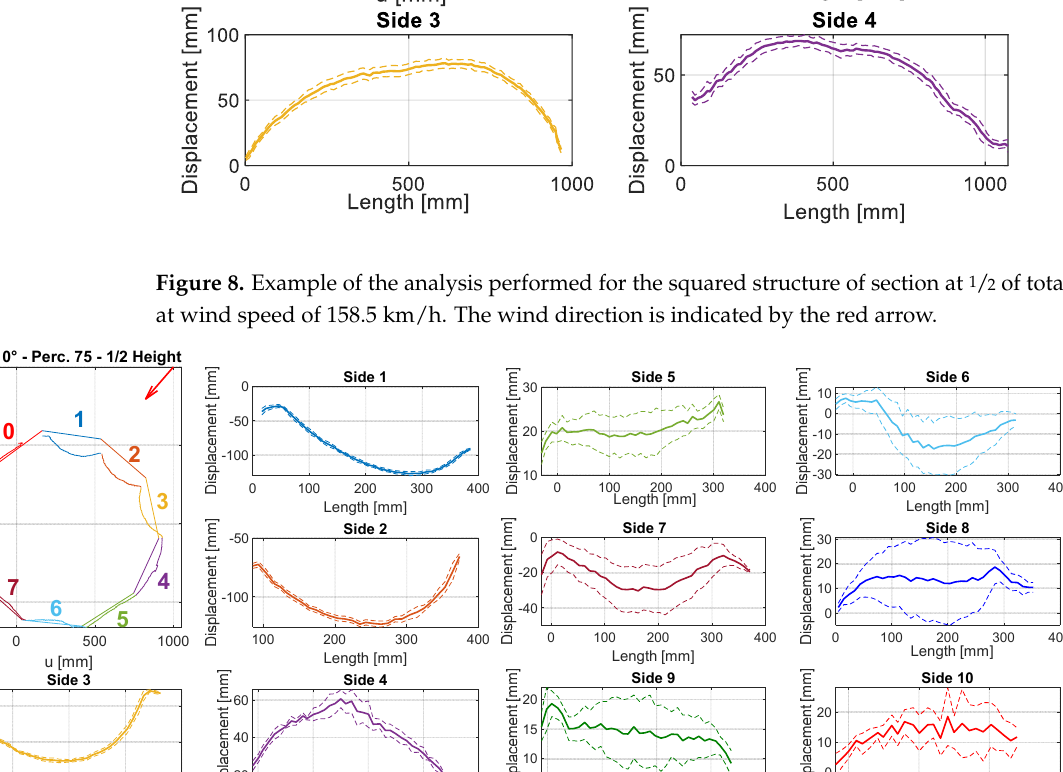
Figure 9. Example of the analysis performed for the decagonal structure of section at ½ of total height at wind speed of 176.5 km/h. The wind direction is indicated by the red arrow.